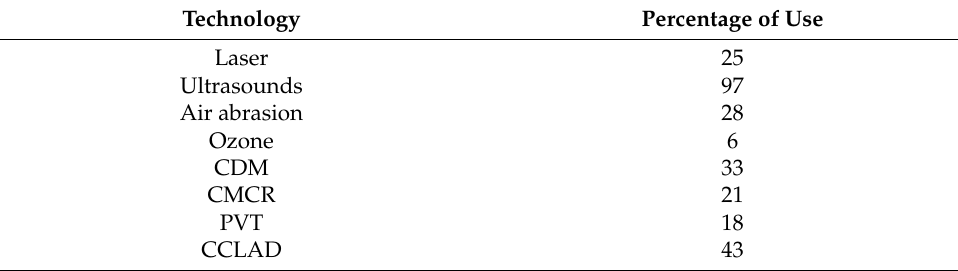
Figure 1. Respondents biometrics. ( a ) Years In practice distribution, ( b ) gender of responding dentists, ( c ) dentist’s form of employment, ( d ) size of practice. The percentage use of each investigated technology is shown in Table 2. Table 2. Percentage of respondents who declare use of each technology.